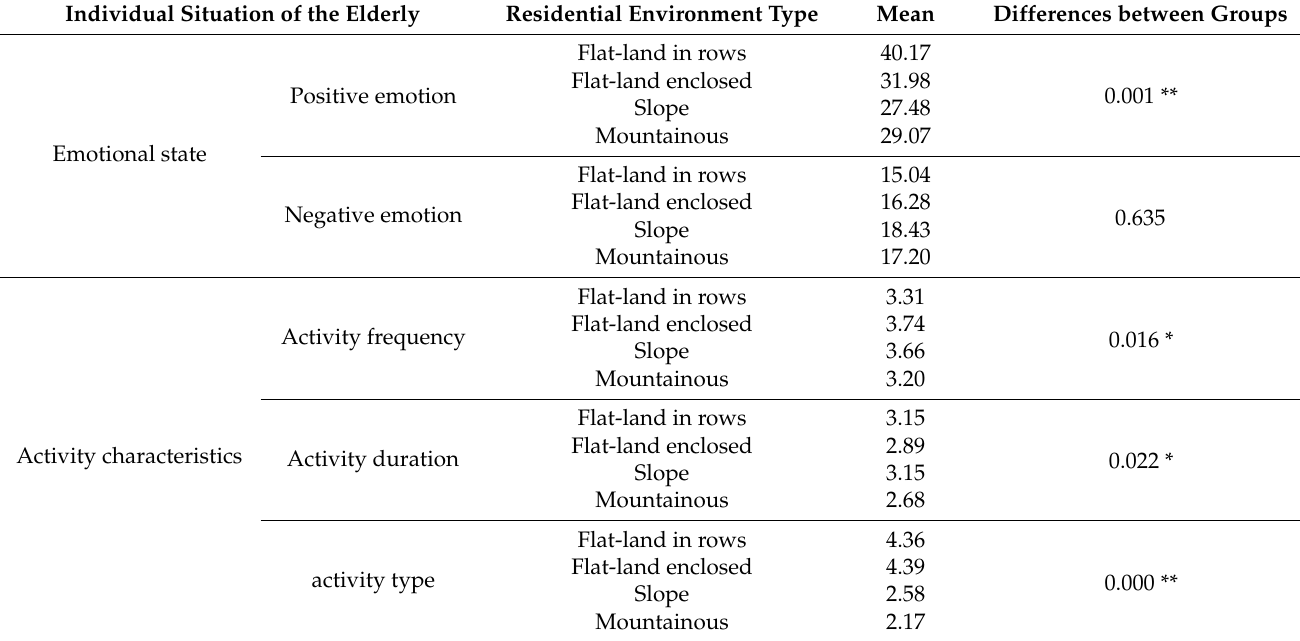
Table 5. Comparison of emotional state and activity characteristics among different types of residential environments. Individual Situation of the Elderly